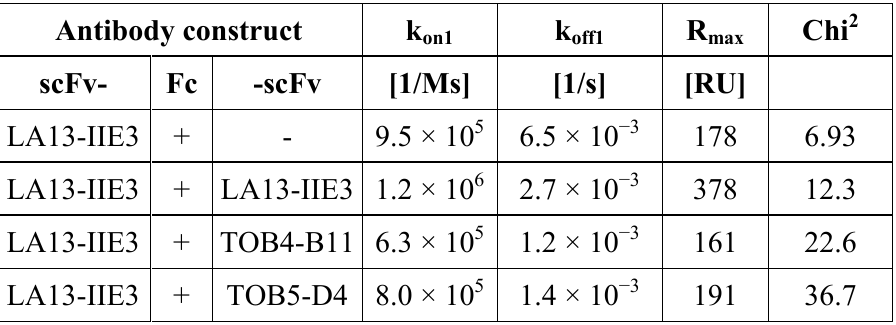
Table 4. Binding kinetics measured by SPR and analyzed using the bivalent analyte